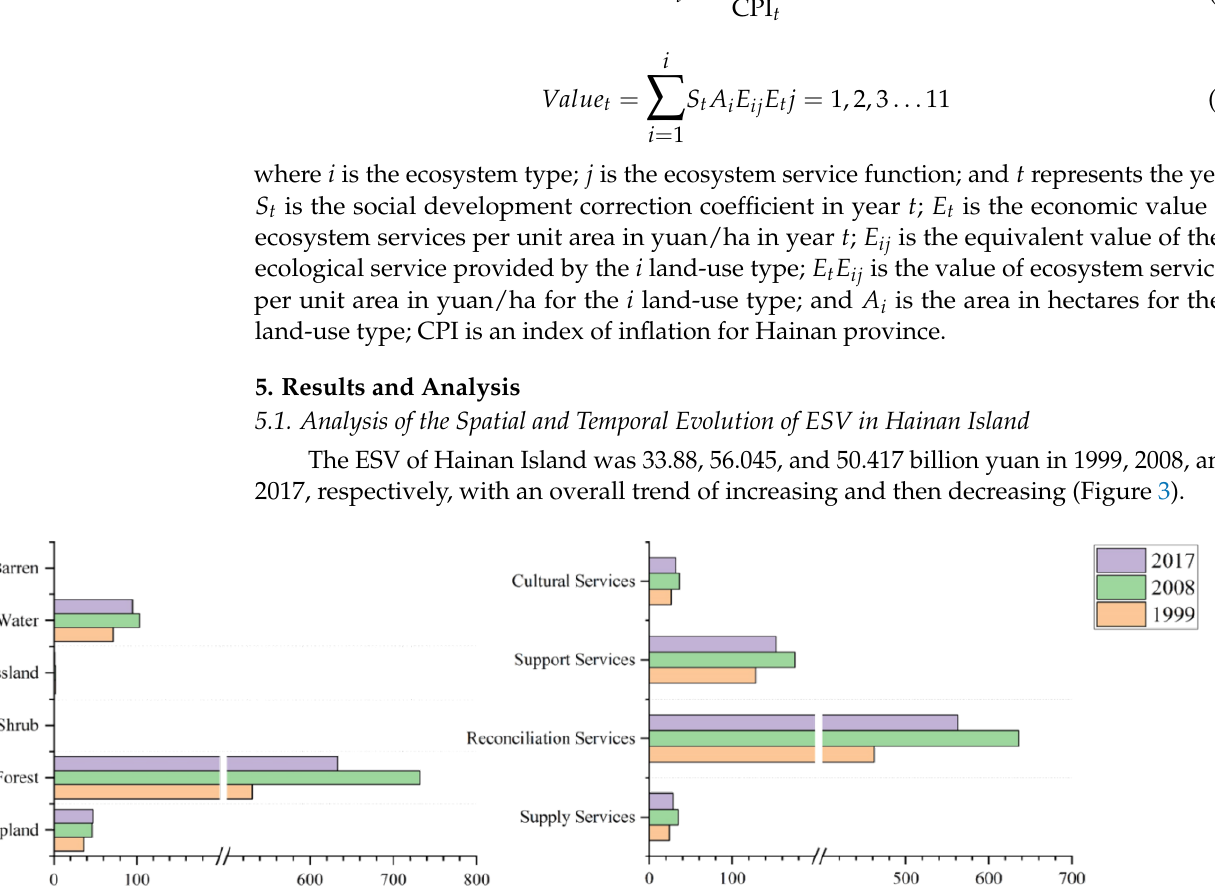
Figure 4. Spatial evolution of ESV in Hainan Island from 1999 to 2017. The structure of ESV land-use types in Hainan Island was relatively stable during 1999–2017; from largest to smallest, the land-use types were ordered as follows: forest land, water, farmland, grassland, shrubland, and wasteland. Forest land accounted for 80% of the ESV. The proportion of water in the land-use types of Hainan Island is small— only about 2%—but it provides the second highest ESV value share, which is mainly re- lated to the water having a large ESV coefficient; therefore, its ecosystem service capacity is very strong. The ESV of forest land increased the most between 1999 and 2008, followed by water and farmland. During 2008–2017, the ESV of forest land decreased the most, followed by watershed and grassland, and the ESV of farmland increased during this pe- riod.